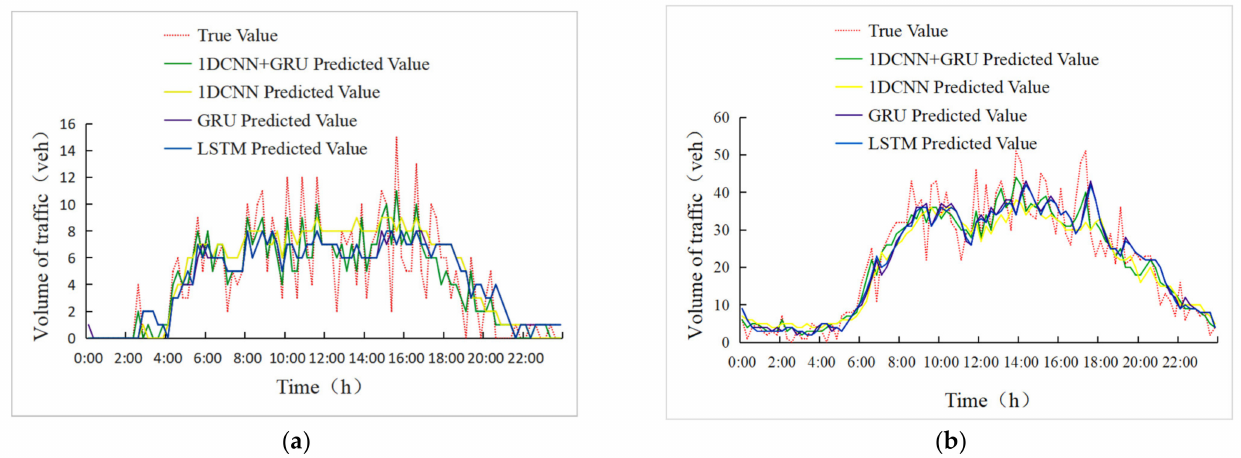
Figure 6. Predictive model comparison results. ( a ) Toll station 17 forecast results. ( b ) Toll station 3 forecast